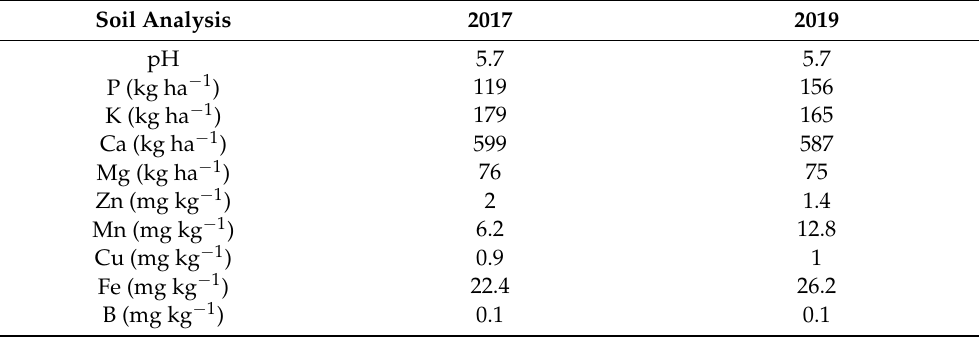
Table 2. Soil analysis in 2017 and 2019 of industrial hemp fields in Randolph Farm Station, Peters- burg,